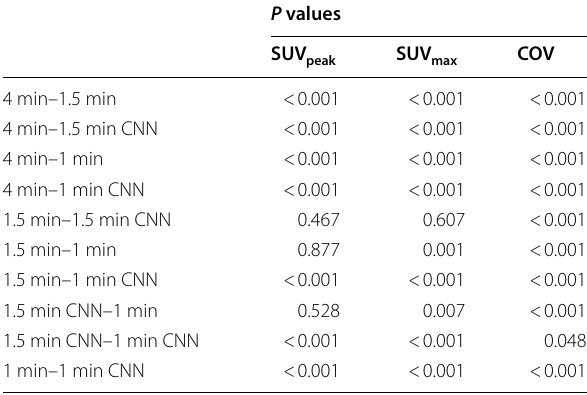
Table 3 Wilcoxon signed-ranks test of all pairwise image